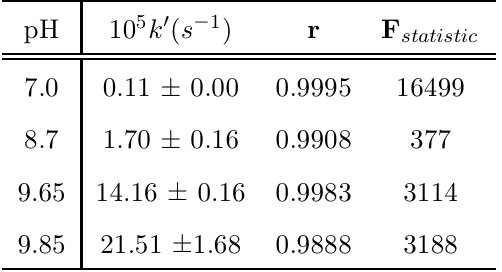
Table 1 Variation of pseudo-› rst rate constant versus pH at 30¸C